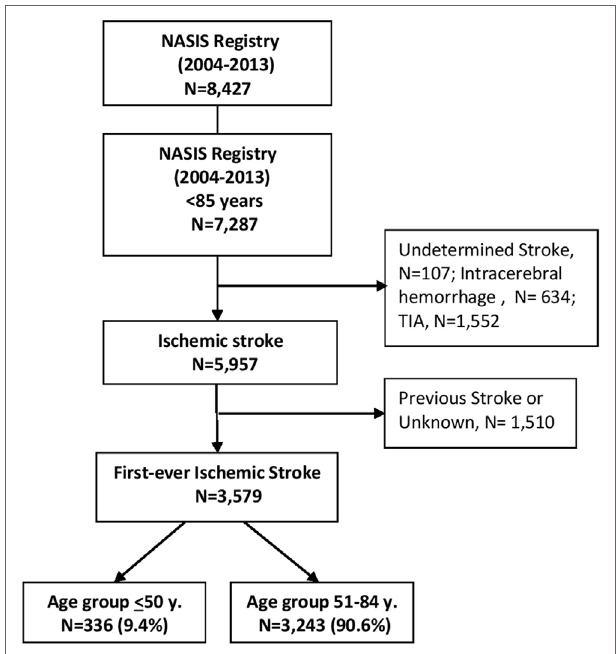
FigUre 1 | Study flowchart.